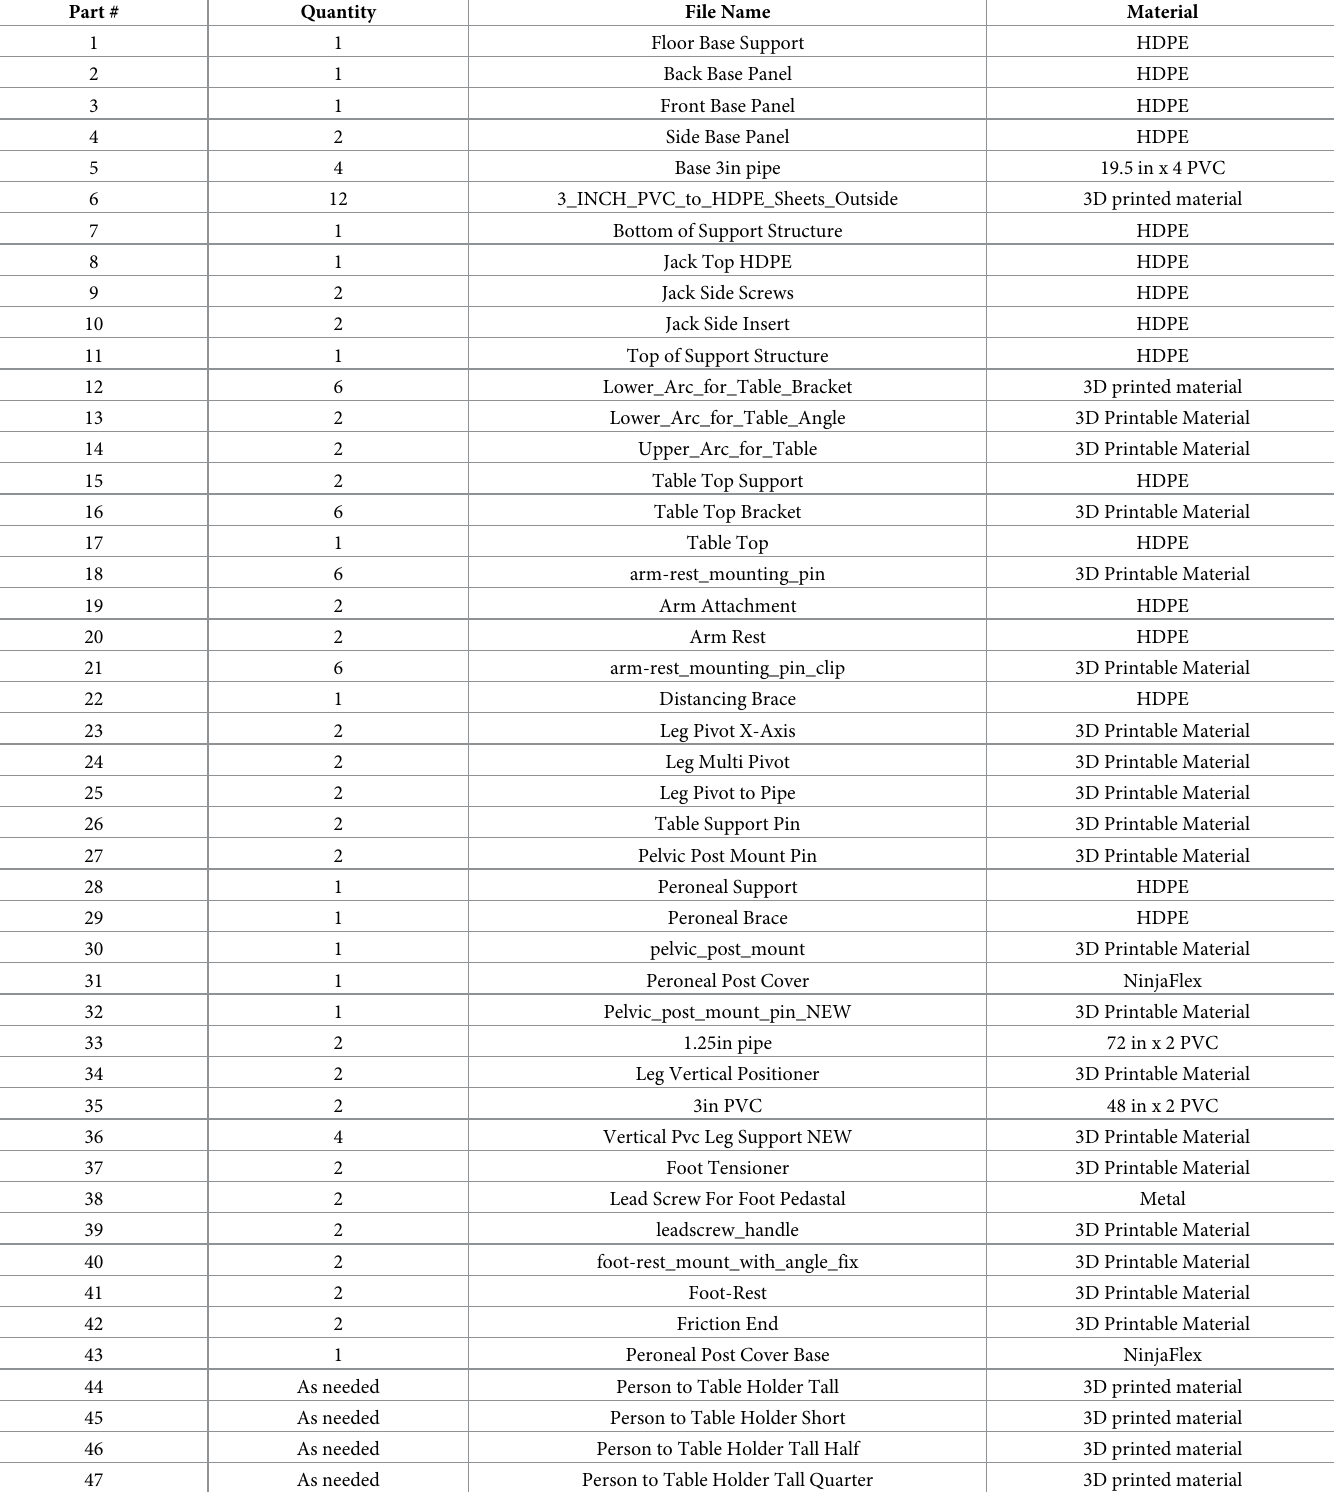
Table 2. Manufactured